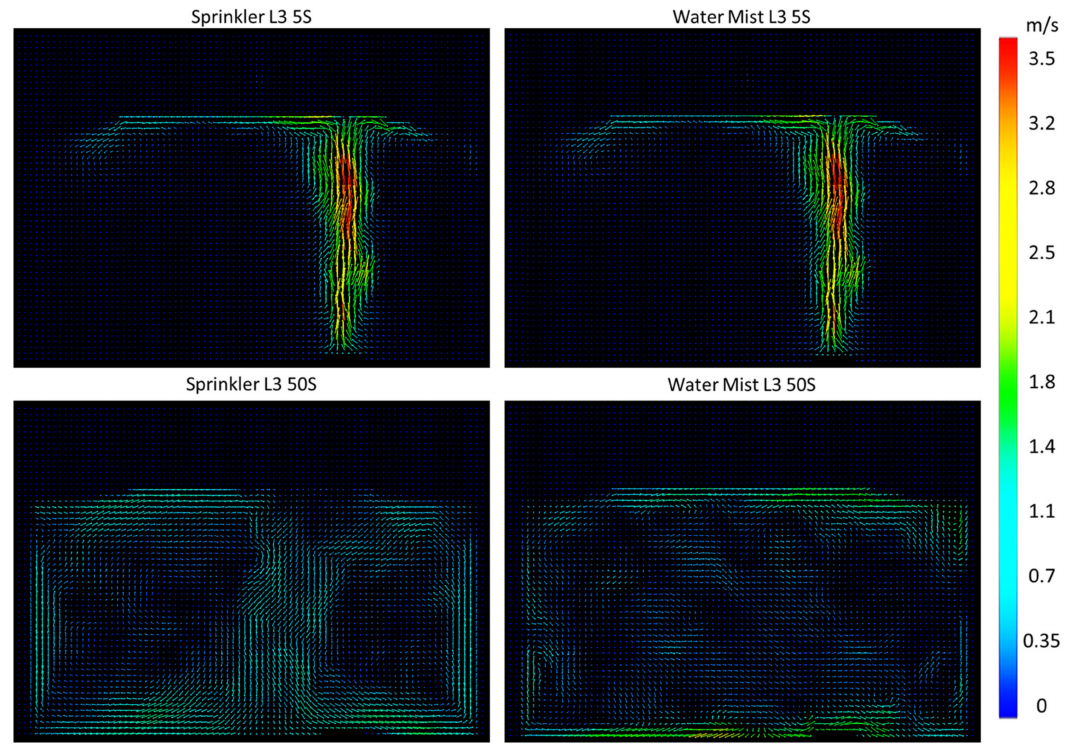
Figure 10. Velocity vector for sprinkler and water mist systems at location 3, before and during fire suppression.